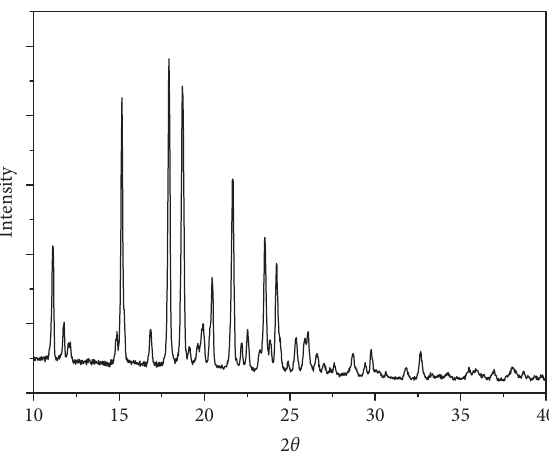
Figure 9: XRD of nickel(II) complex. Figure 10: XRD of copper(II)